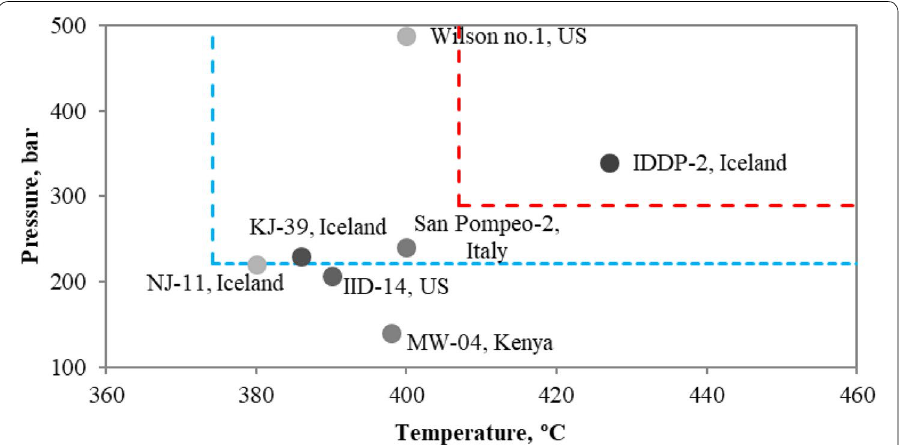
Fig. 2 Maximum reservoir temperatures and pressures measured in geothermal wells, where supercritical conditions were encountered (blue line—the critical point of clean water, red line—the critical point of